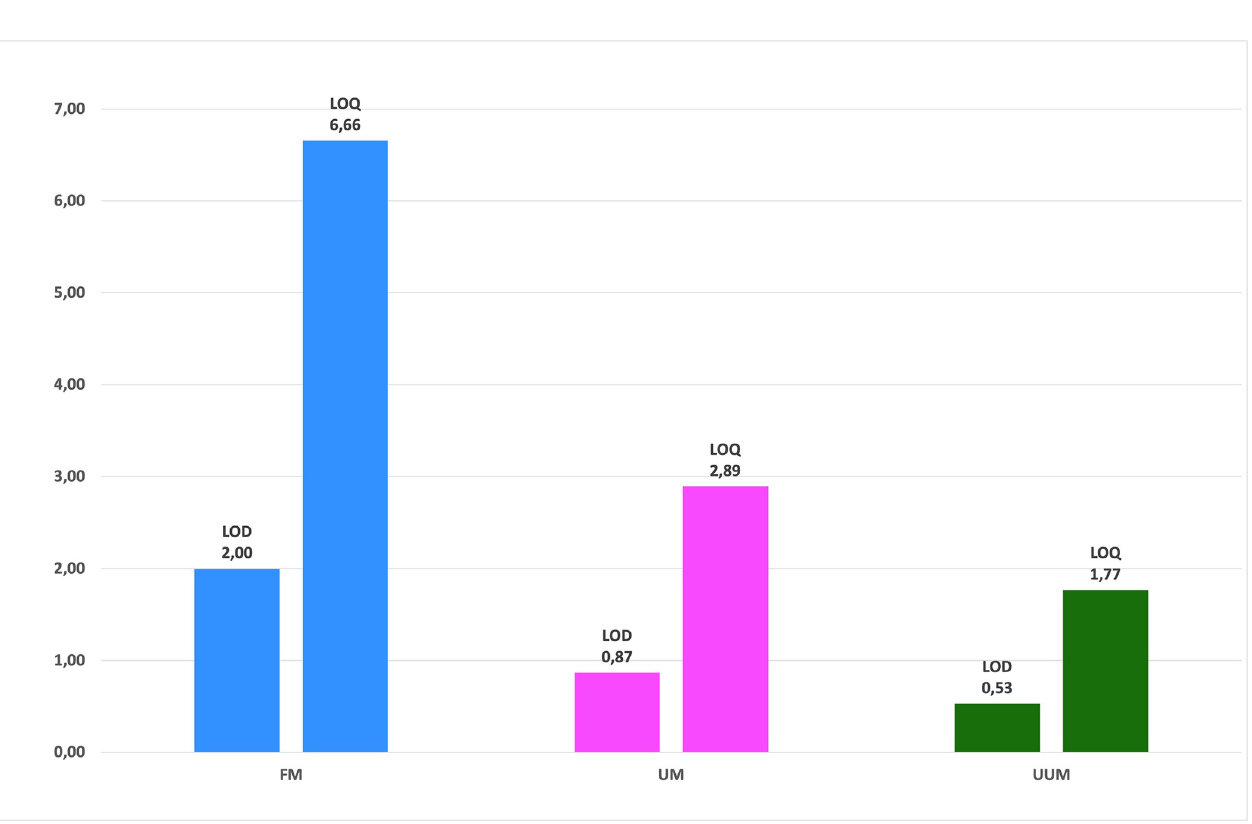
Fig 7. Sensitivity comparison of the FM, UM and UUM methods with the limit of detection and limit of quantification. Calculated by the standard deviation (LOD = 3xSD and LOQ = 10xSD) of the integrals of the three selected noise regions of the spectrum (0.5 ppm, 6.5 ppm and 9.5 ppm) for all the spectra of each method. Normalized concentration values on the